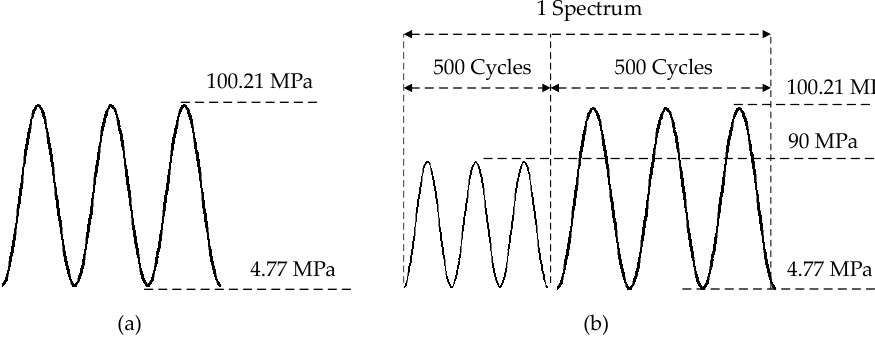
Figure 18. Fatigue loading spectra for lap joint components fatigue test. ( a ) Constant loading spectra for S1–S6; ( b ) variable loading spectra for S7.